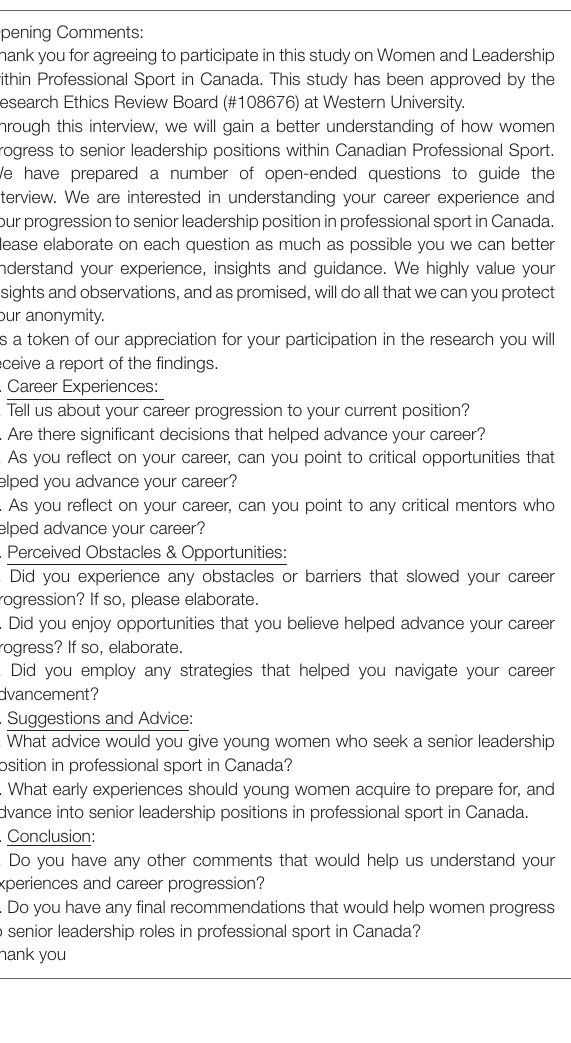
TABLE 1 | Phone Interview Guide for Female Senior Vice